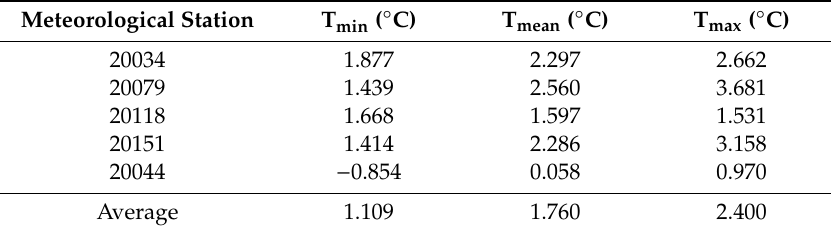
Table 3. Changes in Annual T mean from 1984 to 2014.